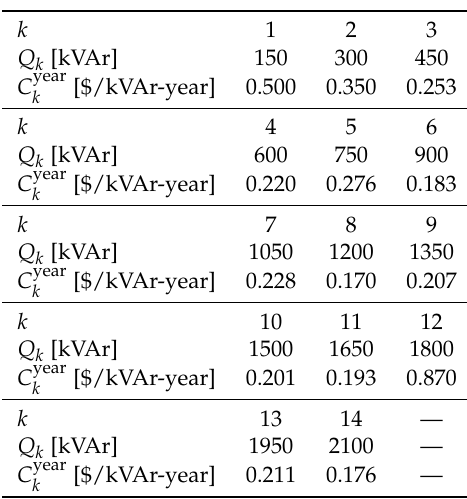
Table 1. Capacitor banks’ information.